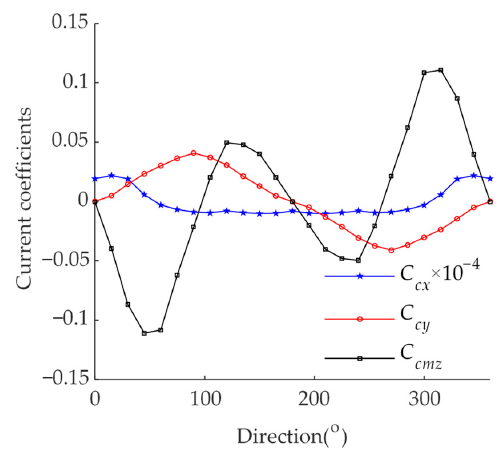
Figure 4. The current coefficients for HYSY201.